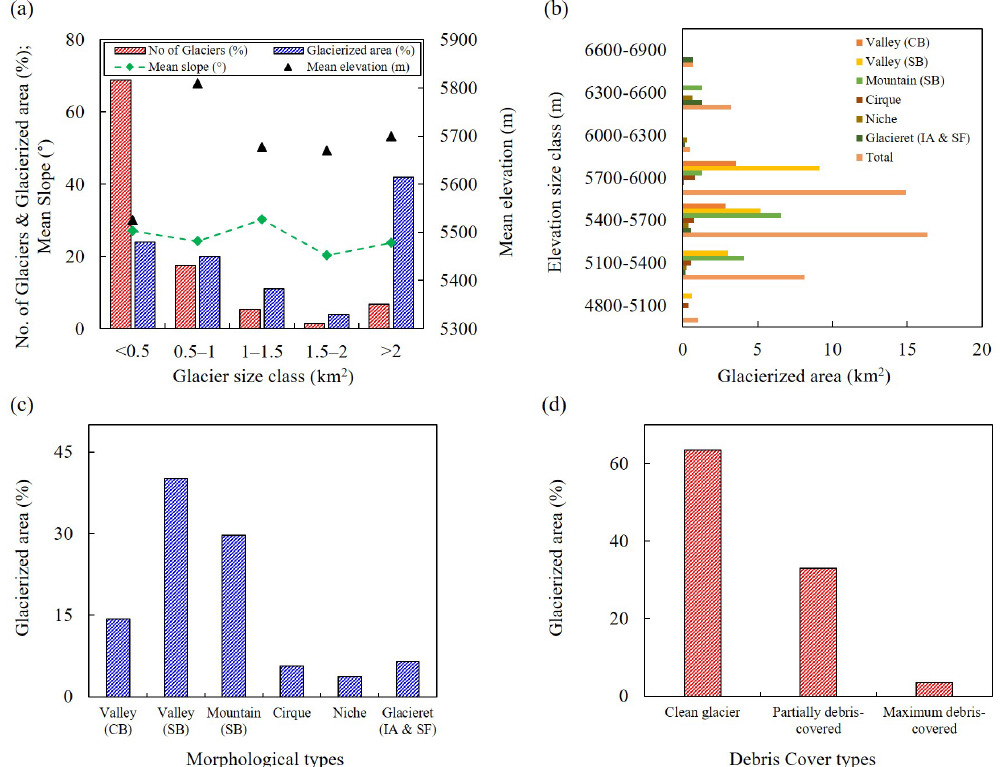
Figure 6. Distribution of (a) number of glaciers, glacierized area, mean slope, and mean elevation as per glacier size classes and (b) elevation size classes of morphological types in relation to glacier area. Frequency distribution (in percent) of (c) glacier morphological types and (d) debris cover types.